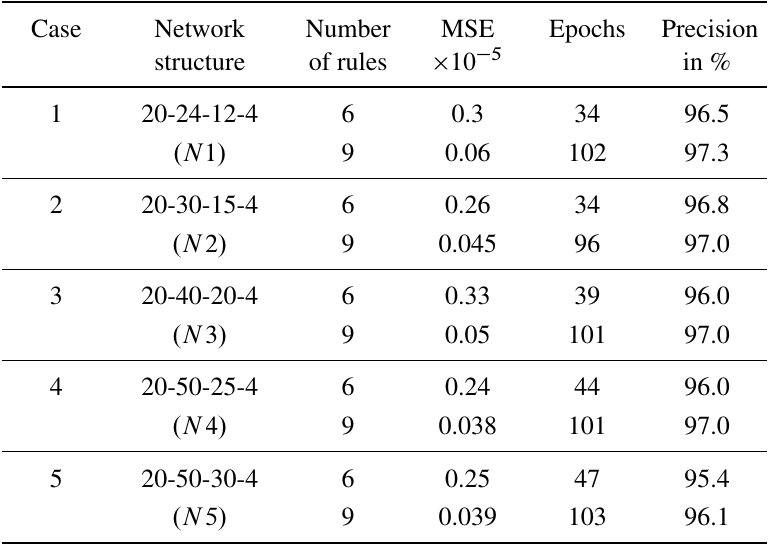
Table 7. Effect in performance due to variation in network structure adopted for implementation of inference